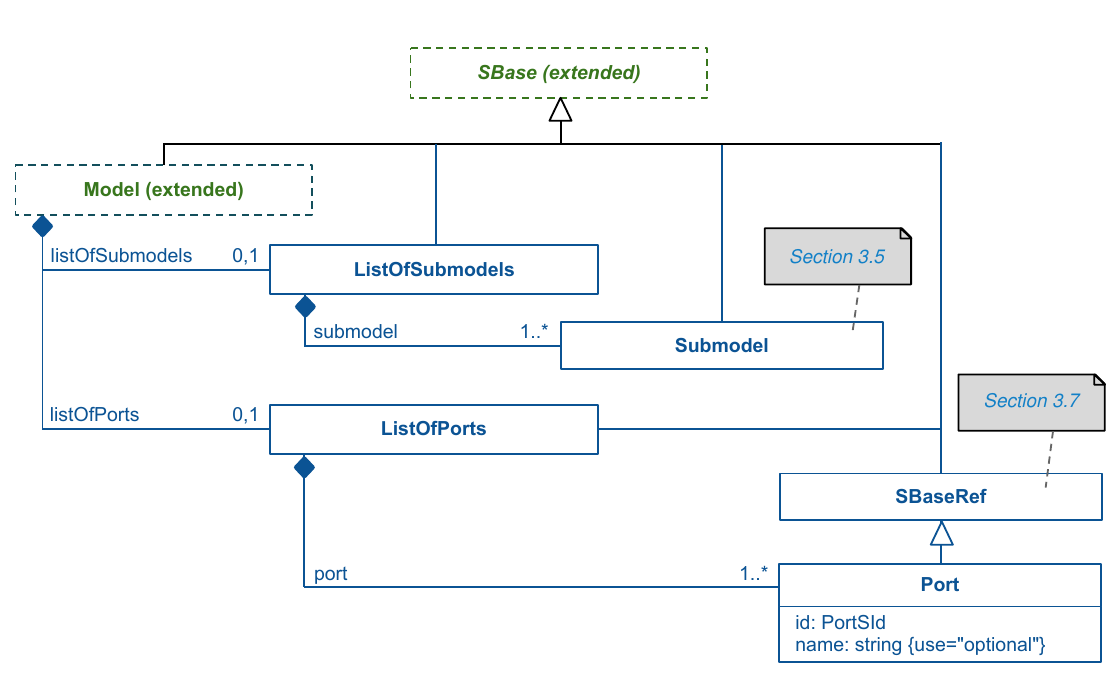
Figure 4: The extensions of the Model class and the definitions of the classes Port , ListOfPorts , and ListOfSubmodels . Submodel is defined in Section 3.5 on the next page and SBaseRef is defined in Section 3.7 on page 26. In other respects, Model remains defined as in the SBML Level 3 Version 1 Core